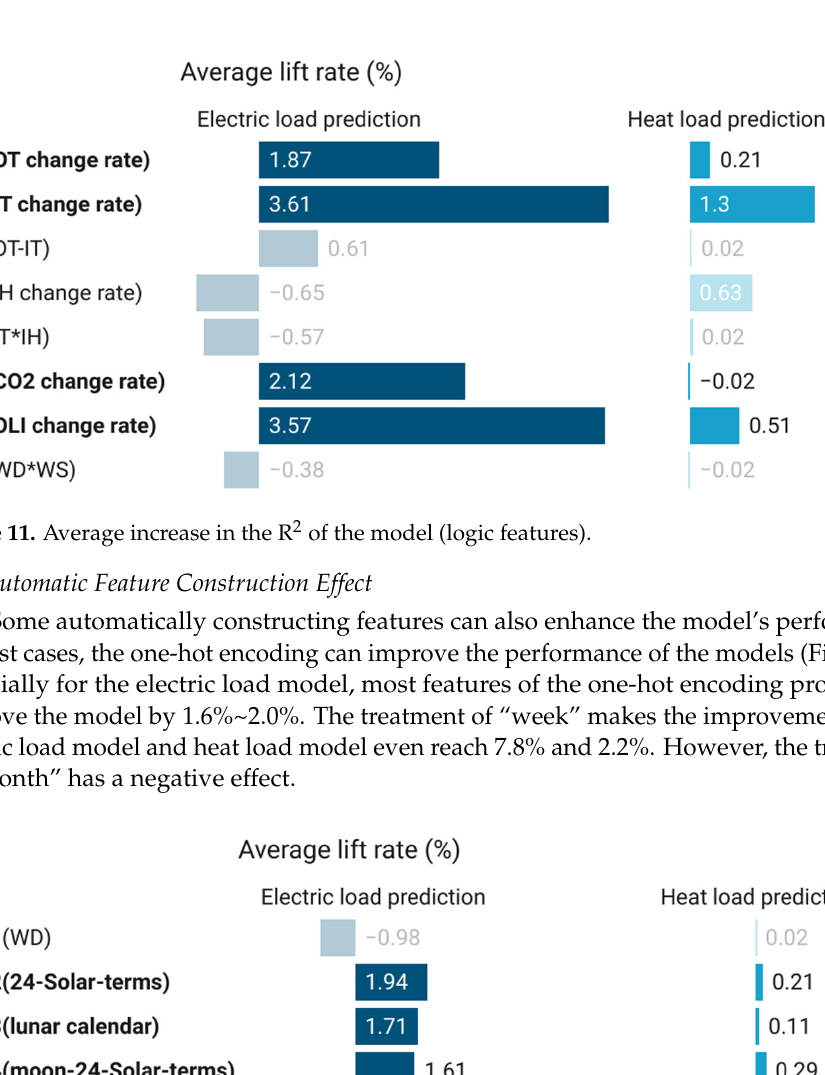
Figure 12. Average increase in the R 2 of the model (one-hot encoding).